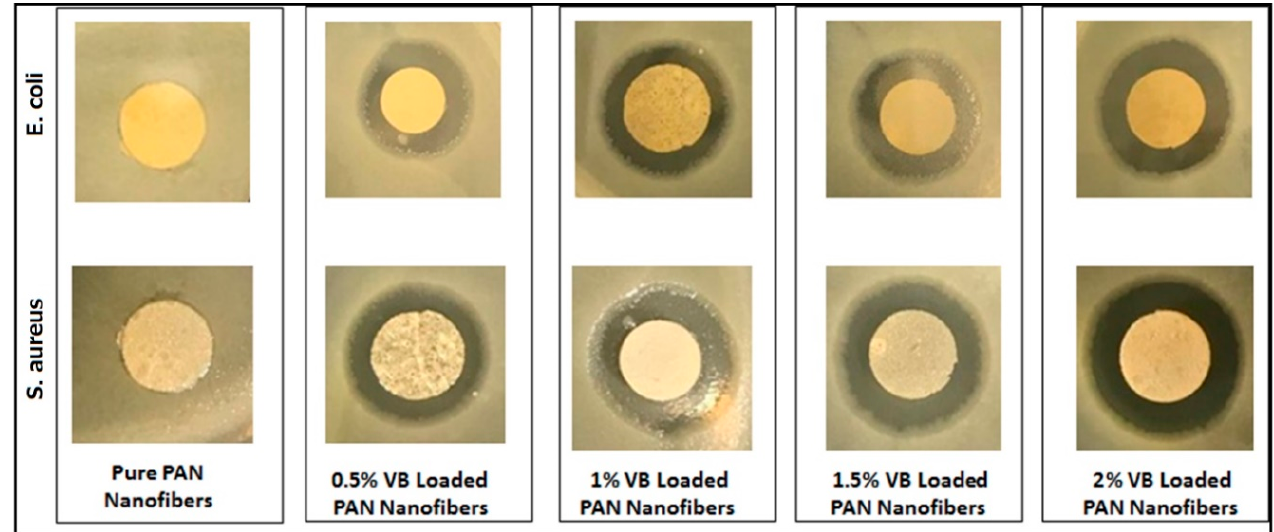
Figure 7. Antibacterial activity of VB-loaded PAN electrospun nanofibers against E. coli and S. aureus bacteria.